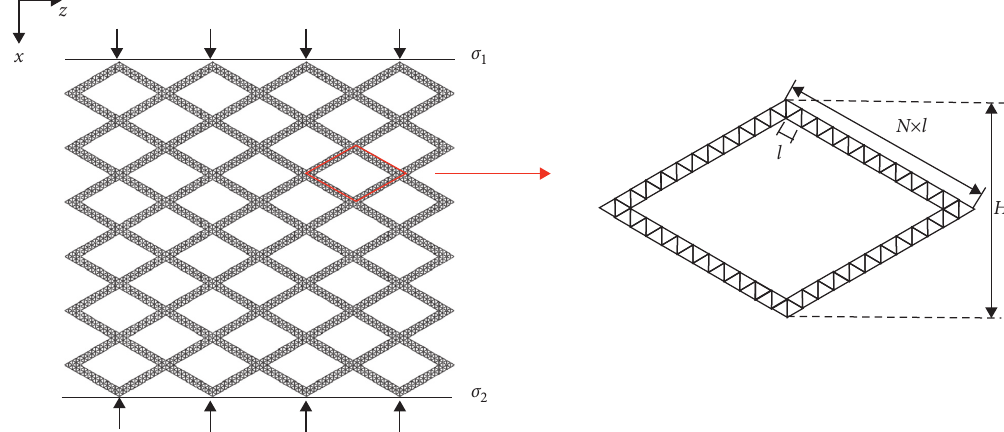
Figure 1: Schematic of a DHH under impact loading in the x direction and its unit